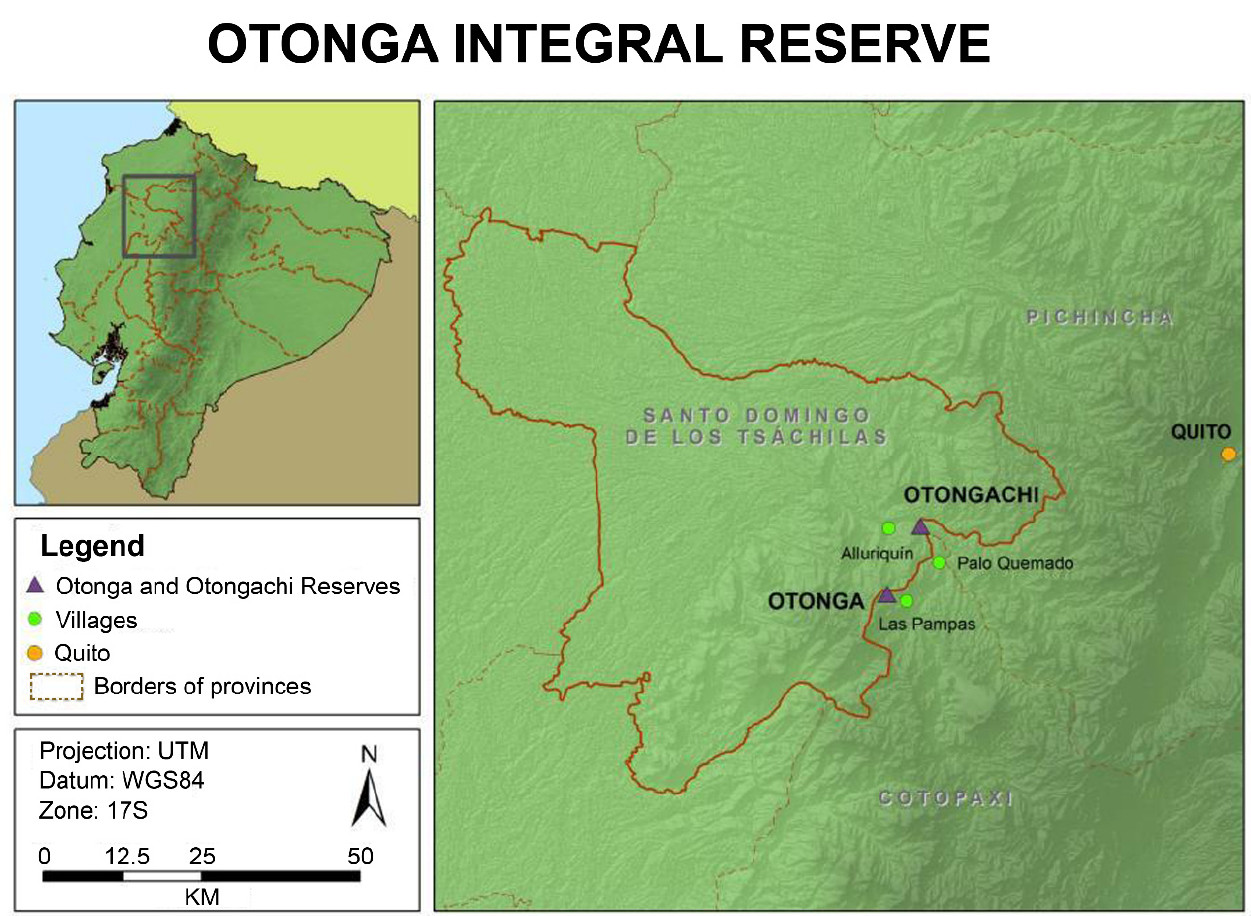
Figure 1. Localisation of the study area.